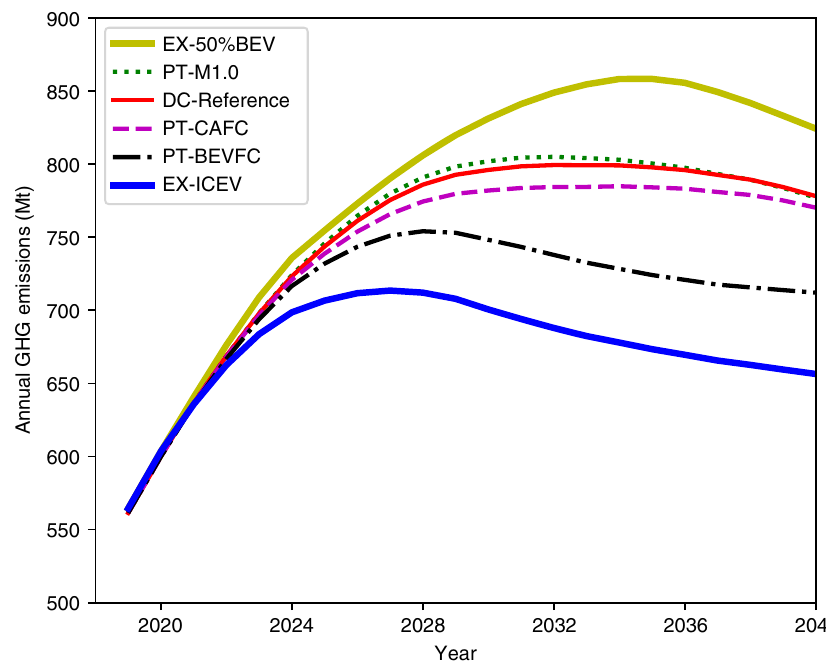
Fig. 1 Annual life-cycle GHG emissions of the LDPV fl eet in China under various policy tweak scenarios and two extreme scenarios. EX-50%BEV: extreme scenario with 50% BEV sales share by 2030; PT-M1.0: policy tweak by setting fuel-ef fi cient ICEV multiplier = 1.0 in the Dual Credit policy; DC- Reference: Dual Credit policy reference scenario; PT-CAFC: policy tweak by removing NEV credit requirements in the Dual Credit policy; PT-BEVFC: policy tweak by setting non-zero FC for NEVs in the CAFC standards; EX-ICEV: extreme scenario by aggressively improving ICEV ef fi ciency.